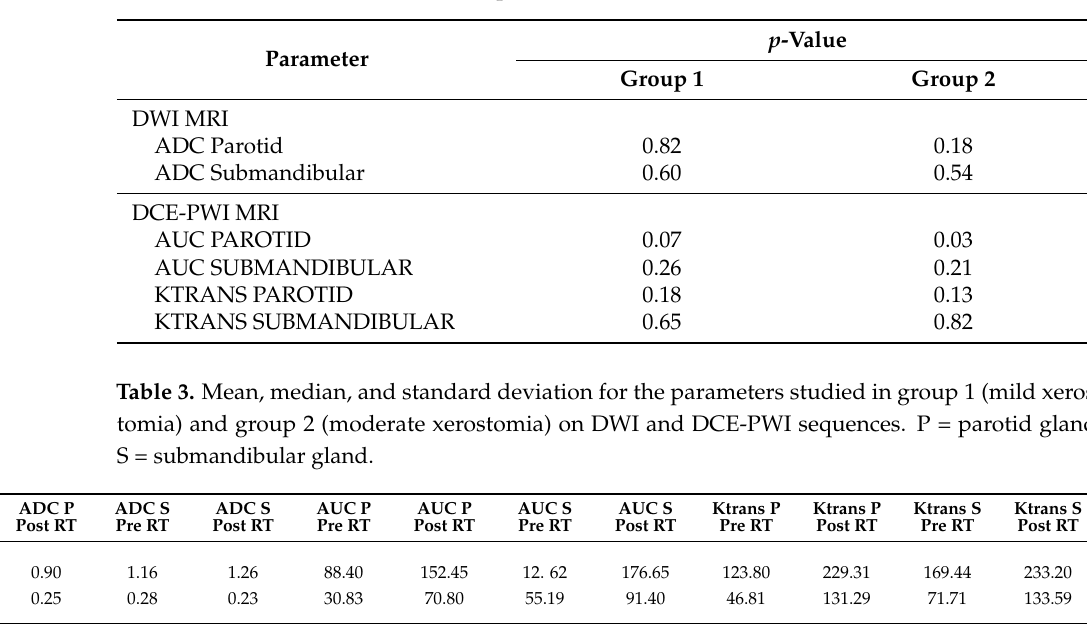
Table 2. p -values for the parameters studied in group 1 (mild xerostomia) and group 2 (moderate xerostomia) on DWI and DCE-PWI sequences.